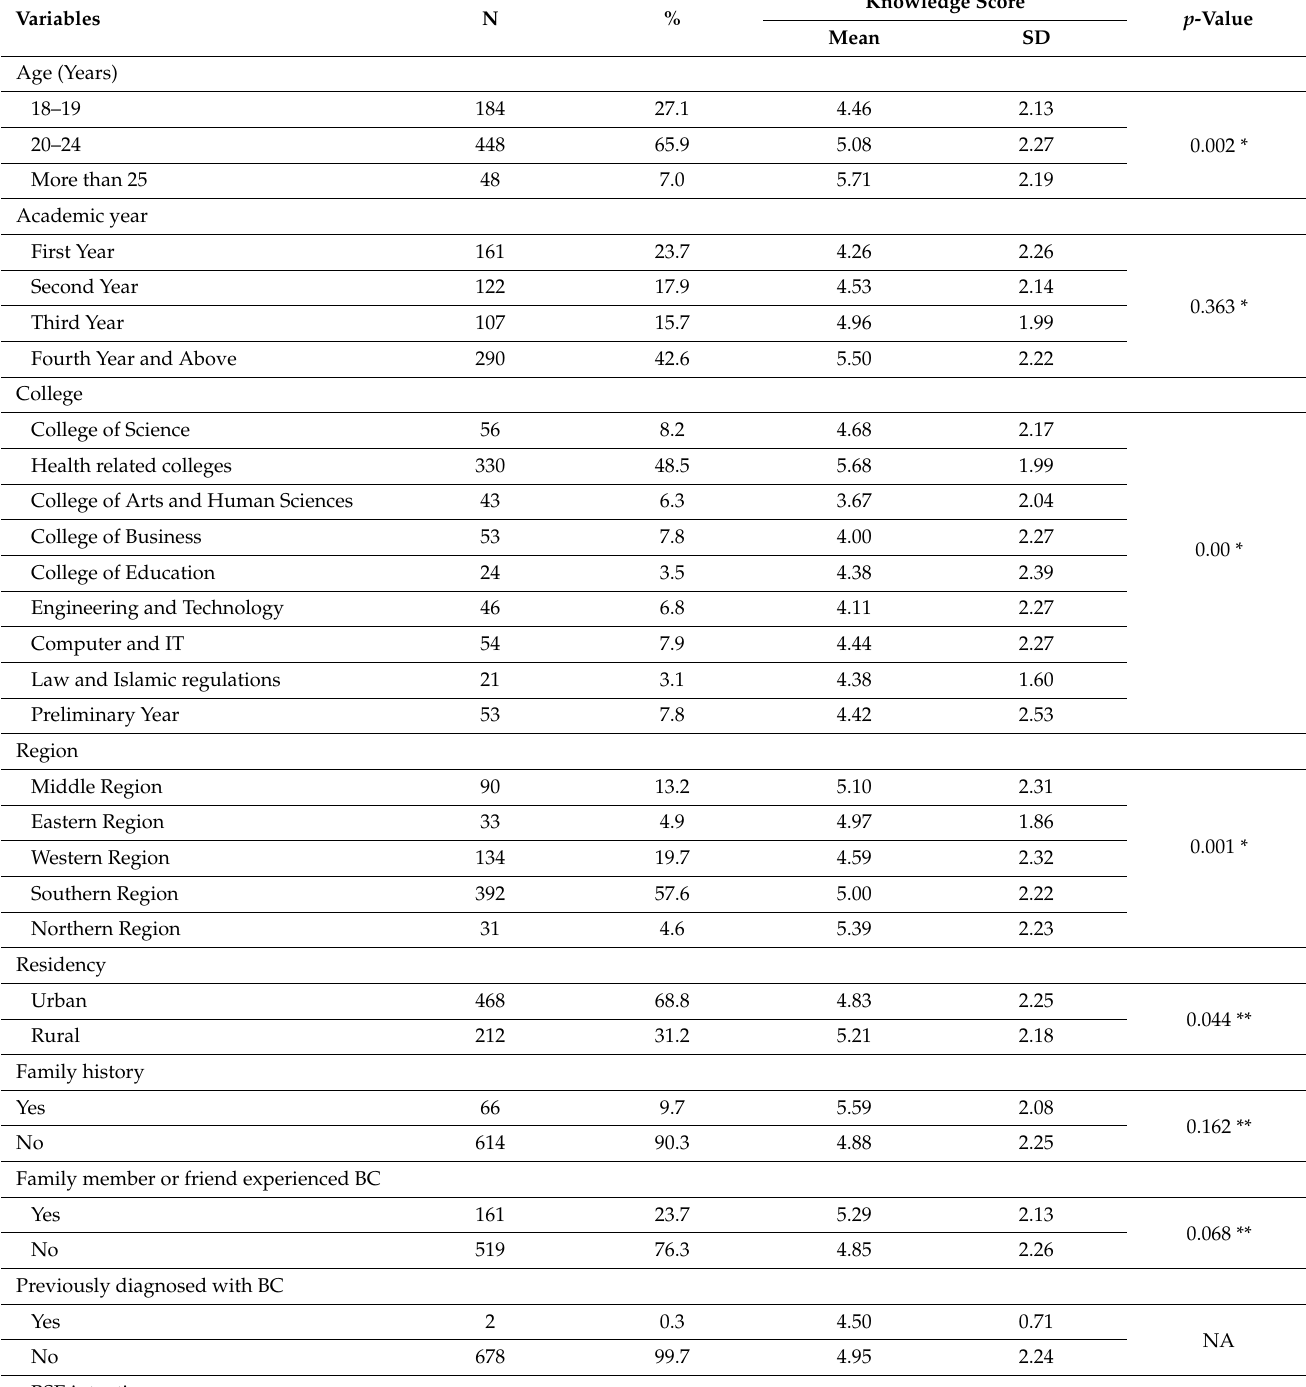
Table 1. Knowledge scores according to the demographic